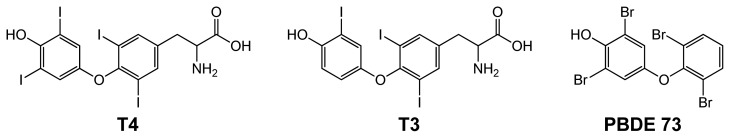
Molecular structures of T4 (left), T3 (mid), and the poly-brominated diphenyl ether PBDE 73 (right).